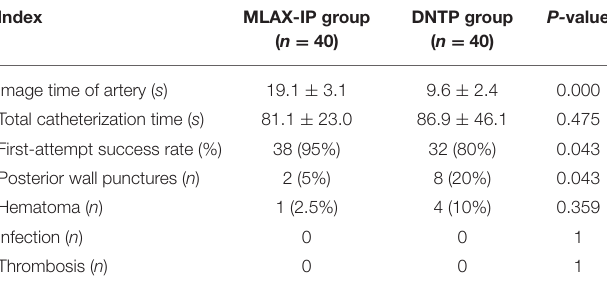
TABLE 2 | Comparison of the variables of puncture between the two